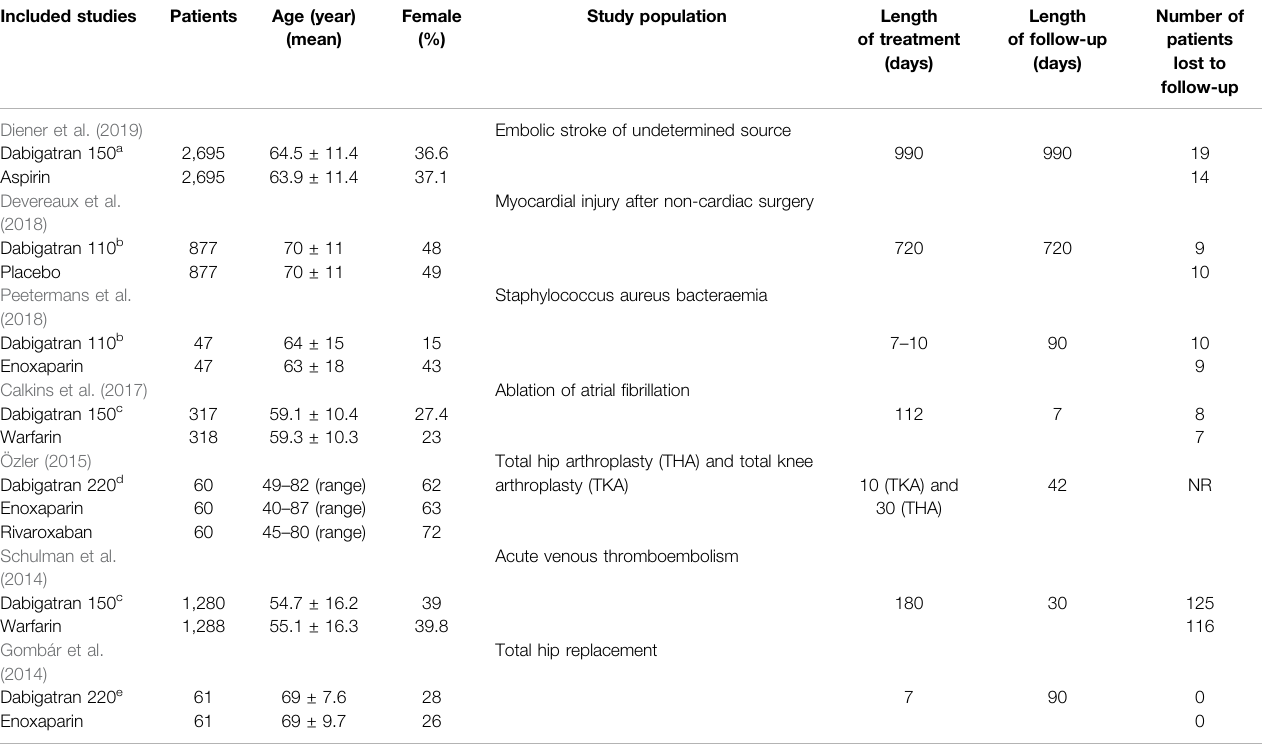
TABLE 1 | Study and patient characteristics of the seven trials comparing dabigatran with control group. Included studies Patients Number of